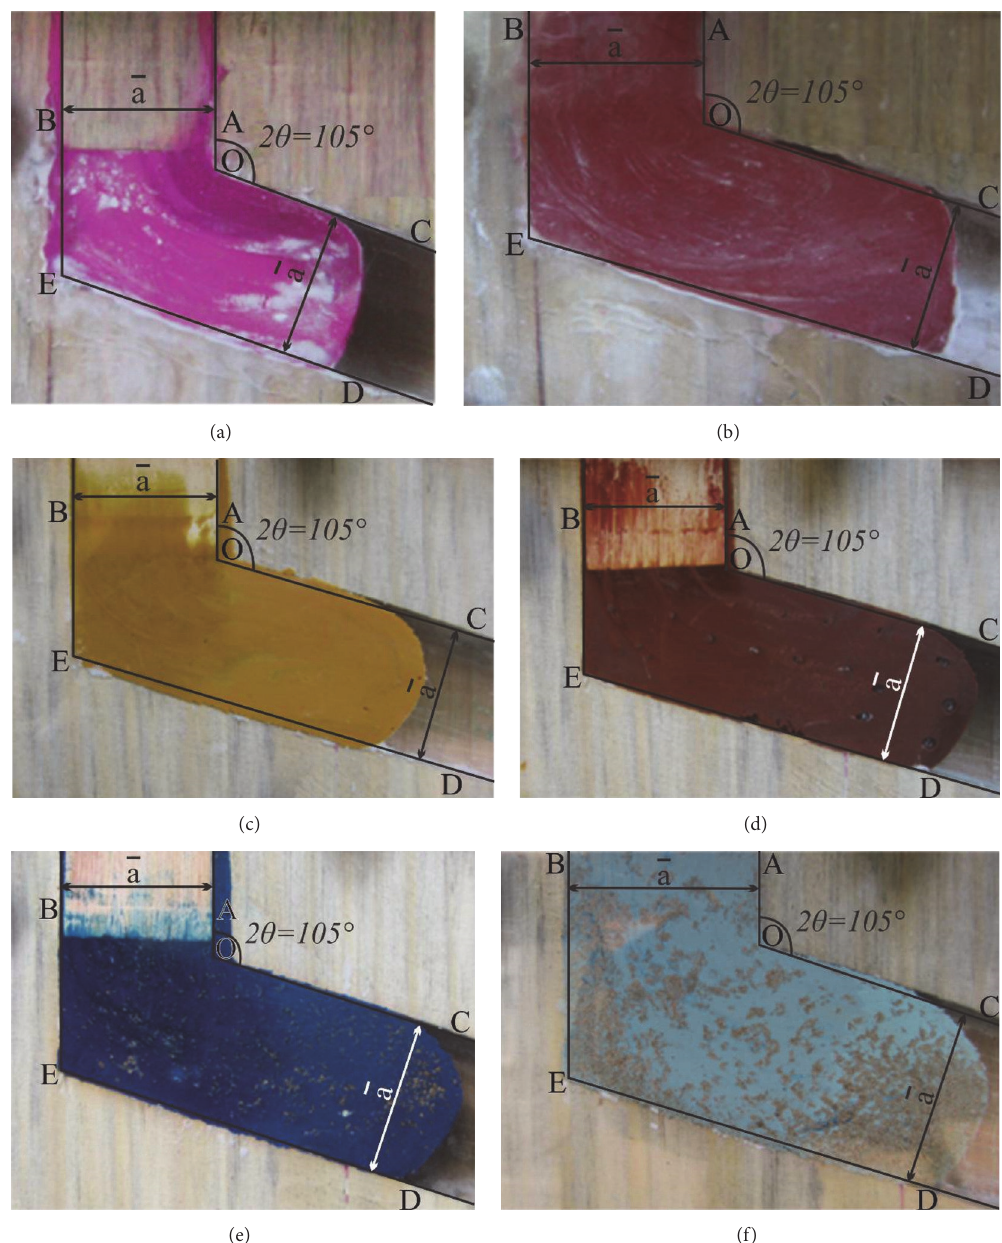
Figure 1: The flow of physical plasticine models of polymer materials through an ECAE die AOC–BED of Segal geometry with channel intersection angle ∠ (BED) = ∠ (AOC) = 2 𝜃 = 105 ∘ : (a), (b), (c) the flow of uniform plasticine workpieces; (d) the flow of plasticine workpiece with additional solid markers at the front surface of workpiece in the shape of the hard spots; (e), (f) the flow of plasticine workpieces with additional dispersed particles on the front surfaces of workpieces in the form of partially immersed fine sawdust.